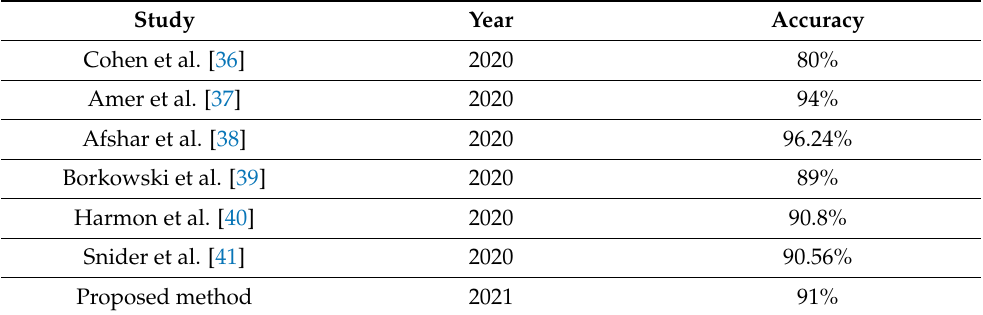
Table 2. Accuracy comparison for the proposed model and other published models for a similar purpose. Study Year Accuracy Cohen et al.